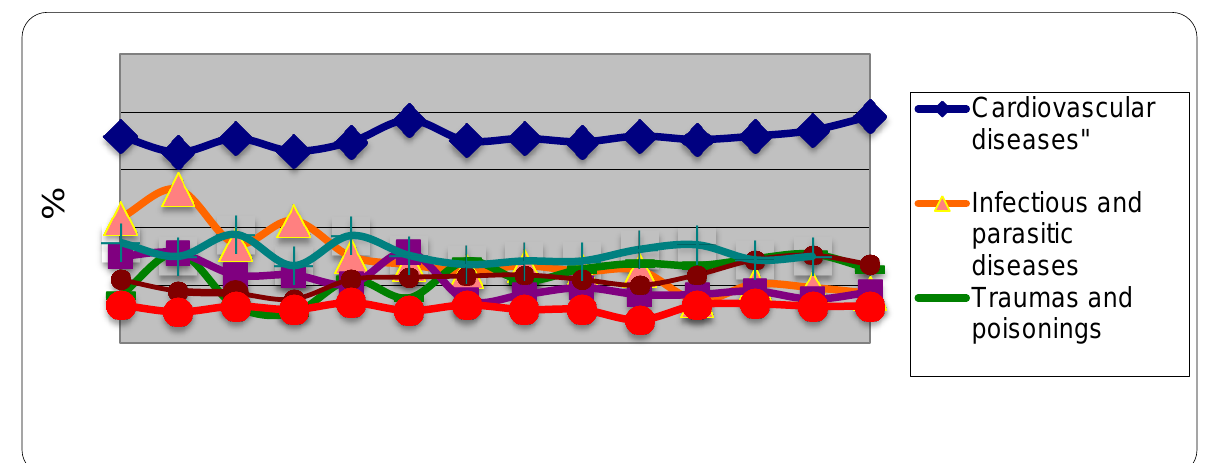
Figure 7: Structure of premature disability of the Kyrgyz Republic population (according to Republican medical and informational centre,